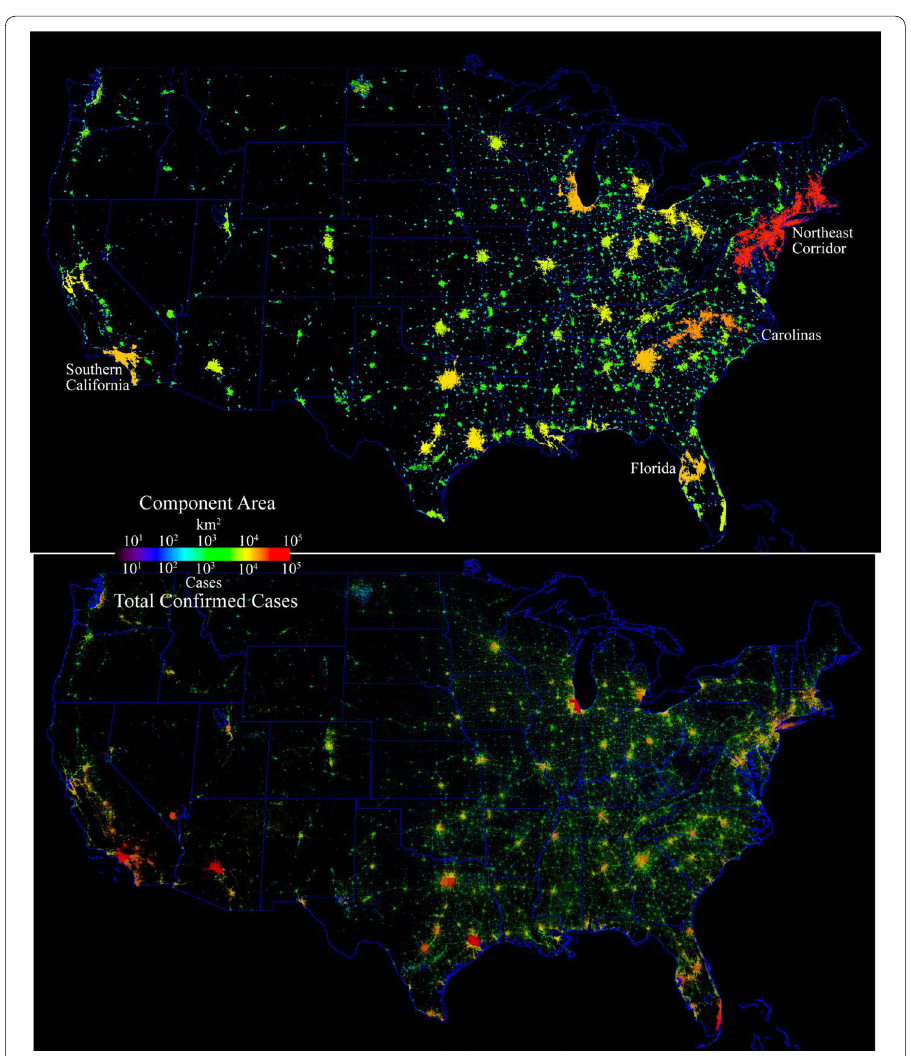
Fig. 5 Network component area map and county level confirmed case distribution for the USA. At this scale, the large number of smaller components with fewer cases are not resolved. Case density scales with population density, with the largest numbers in dense urban cores throughout the country. In contrast to China, there is no single epicenter but many large cities with > 10 4 cases. Similar to China, there are case density gradients within the larger network components. Enlarge to see